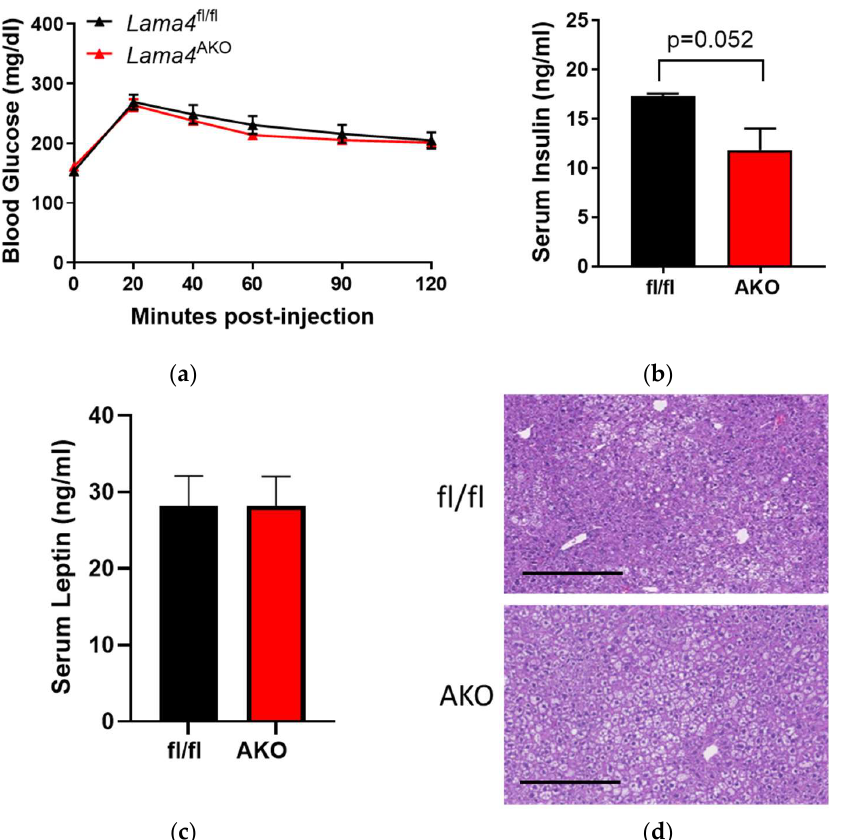
Figure 4. Glucose tolerance is unchanged and postprandial insulin levels are decreased in chow-fed mice with adipocyte-specific LAMA4 deletion. Male Lama4 fl/fl and Lama4 AKO mice were provided a chow diet from weaning until 24 weeks of age. ( a ) Intraperitoneal glucose tolerance tests were performed after 18 weeks on diet ( n = 15–16 mice per genotype after a 4-h fast). Serum ( b ) insulin levels and ( c ) leptin levels in fed mice ( n = 6 per genotype) were measured by ELISA. ( d ) Representative images of H&E-stained liver sections ( n = 5–7 per group), demonstrate no differences in hepatic lipid accumulation. Scale bars = 250 μm.